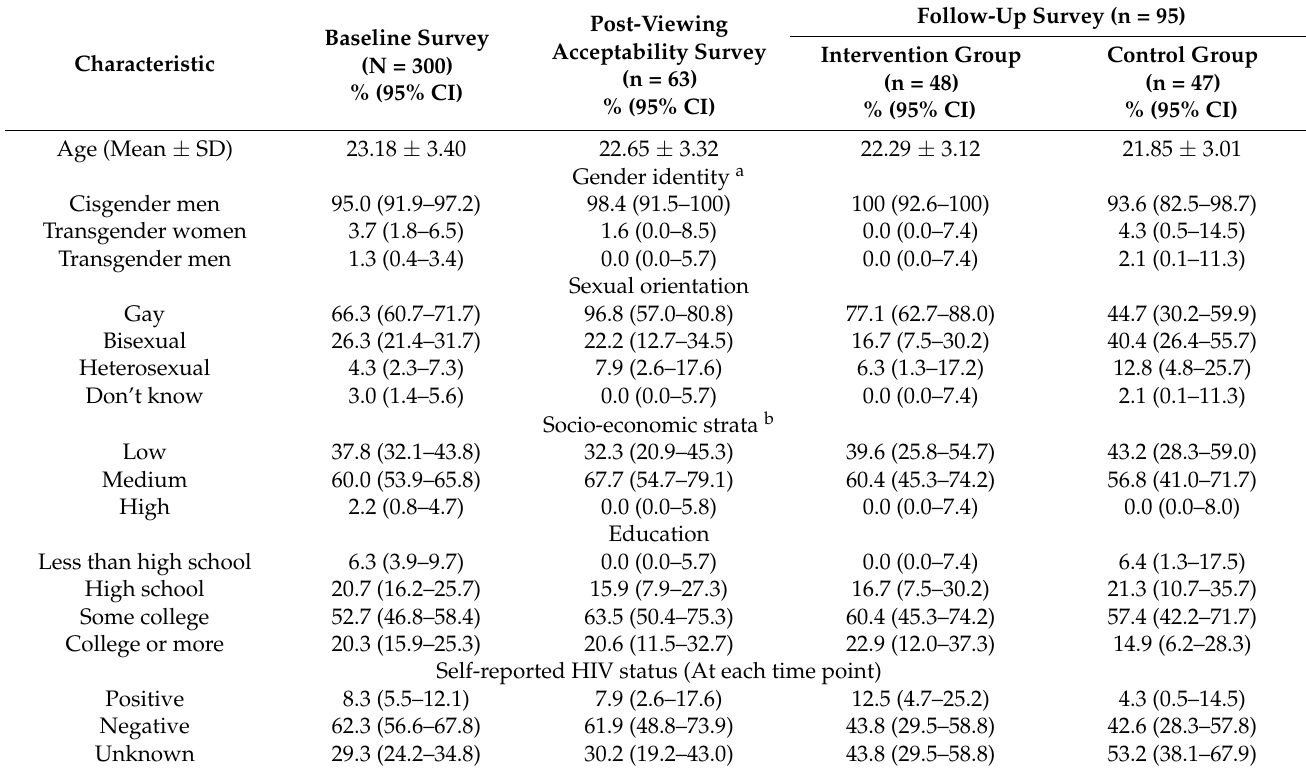
Table 2. Baseline demographic characteristics of participants by group and time